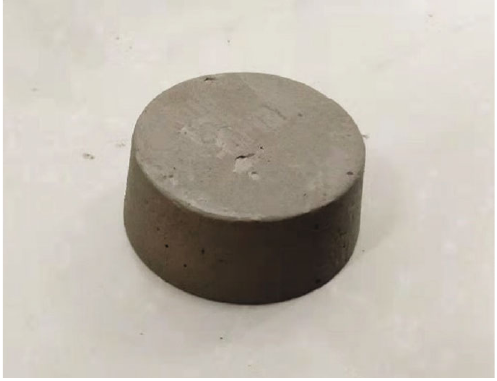
Figure 4: Mixing the components.